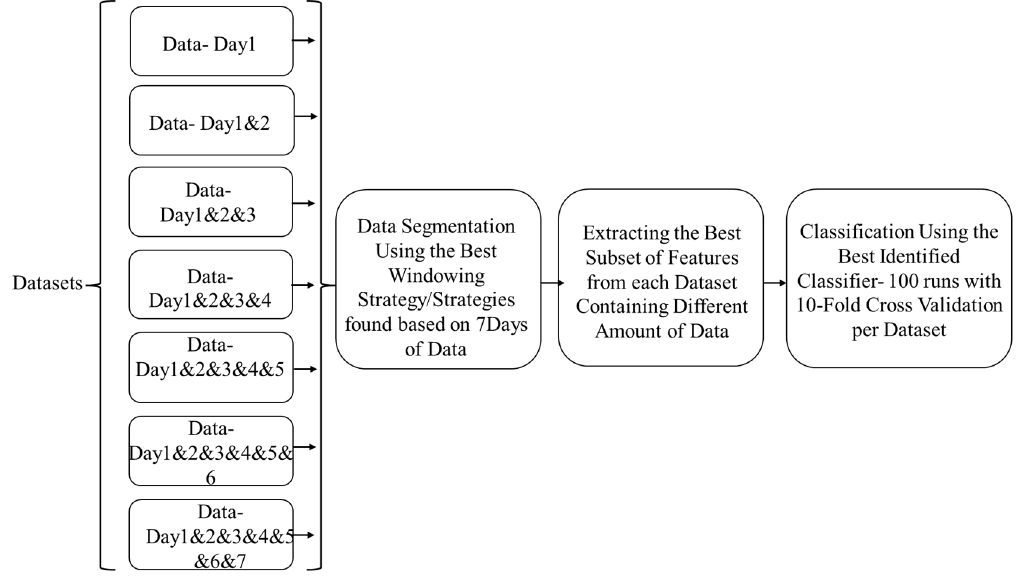
Figure 2. Steps to identify the optimal amount of data in terms of days.